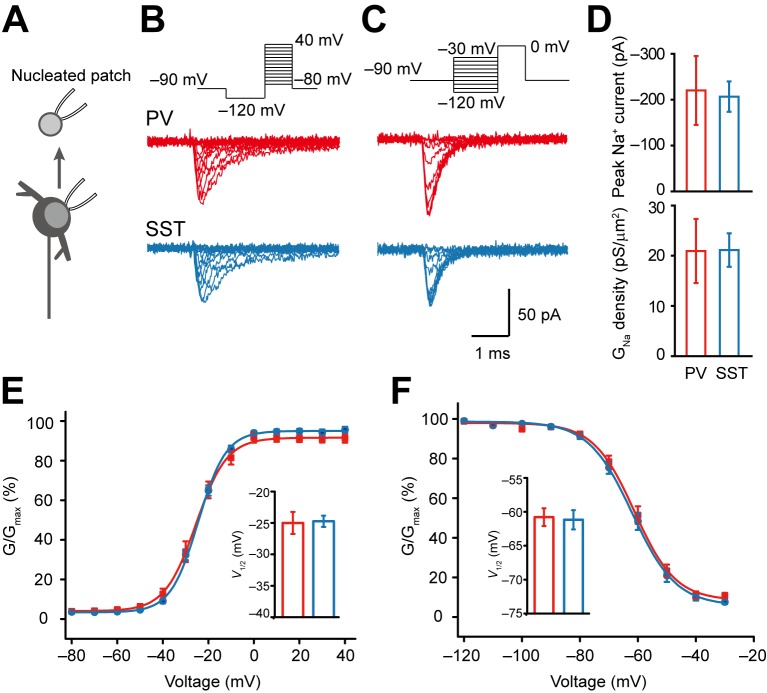
Voltage dependence of somatic Na+ channels.(A) Schematic diagram of recording from somatic nucleated patch (i.e., giant outside-out patch of somatic membrane). (B) Example current traces evoked by activation voltage commands (top) in PV and SST nucleated patches. (C) Current traces evoked by the test pulse (0 mV) in the voltage protocol for channel inactivation. (D) Comparison of averaged peak Na+ currents and conductance density in nucleated patches. Error bars represent s.e.m. (E and F) Activation and availability curves of somatic Na+ currents in PV (red) and SST neurons (blue). (Insets) Comparison of the activation and inactivation V
1/2, showing no difference between the two cell types. Error bars represent s.e.m.